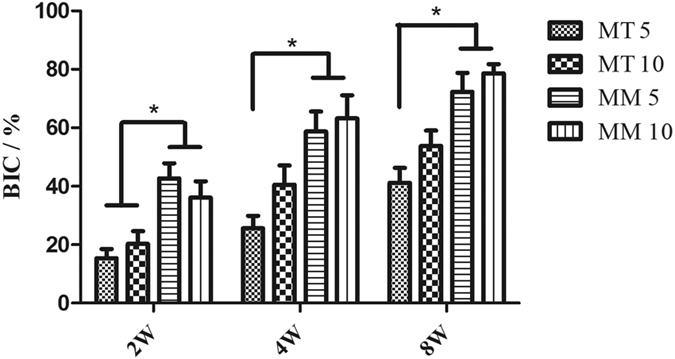
Calculated bone-implant contact of HP Mg screws in different groups.*p < 0.05.